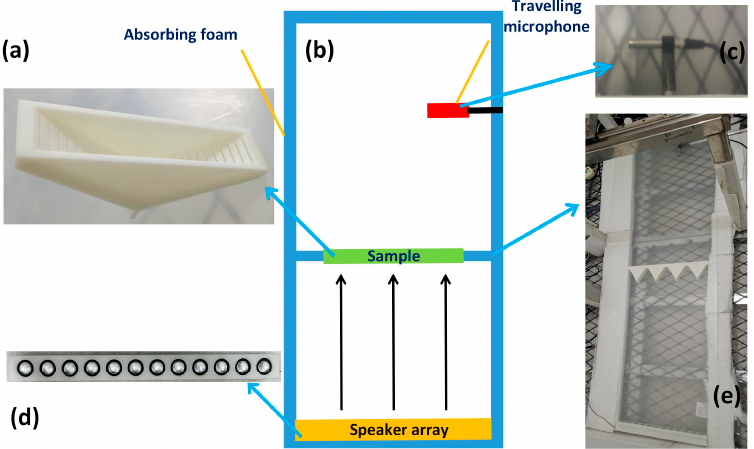
Figure 3. ( a ) Sample. ( b ) Diagram of the experimental system. ( c ) Travelling microphone. ( d ) Sound source. ( e ) Test environment.